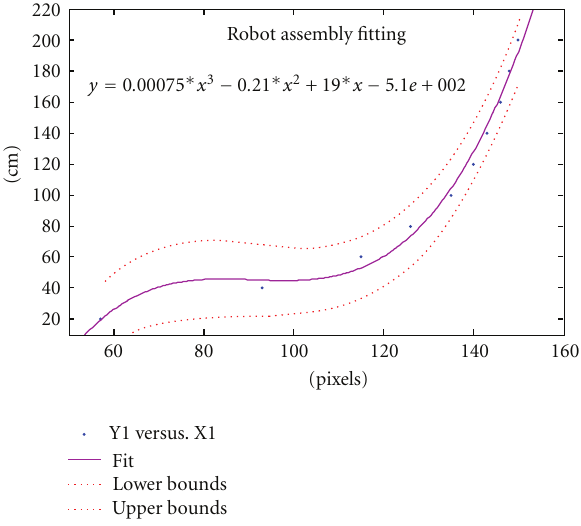
Figure 14: Polynomial interpolation functions.